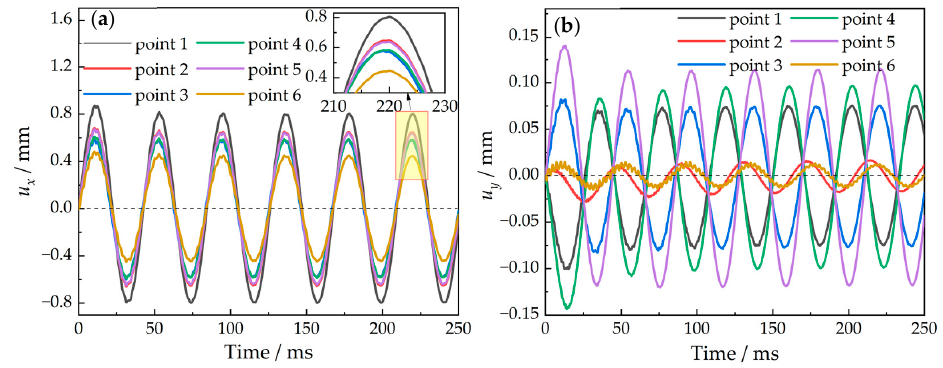
Figure 8. The time history of ( a ) u x and ( b ) u y of the representative points. The feeding channel deformed periodically under vibration, and its deformation am- plified 100-fold at 220 ms and 240 ms is shown in Figure 9. The distortion of the mesh reflected the deformation of the melt micro-units. The displacement was large in the upper feeding channel, but the deformation was small. Conversely, the displacement was small in the lower region, but the deformation was large. The maximal deformation region near the 642 °C isotherm is marked by a red line and named region A in Figure 9a,b. In the positive half-period of the source, the feeding channel was pushed, forming tensile stress in region A, where the dendrites overlapped slightly with weak strength [26]. When the tensile stress reached its maximum, such as at 220 ms, region A developed cracks easily, as shown in Figure 9a. In the negative half-period, the feeding channel was pulled, form- ing compressive stress in region A to press the cracks, as shown in Figure 9b. However, the strength increased with solidification, and the cracks were in a vacuum, promoting the discharge of the gas dissolved in the melt, increasing the resistance to being pressed. If the cracks were not pressed and the melt was not supplemented in time, hot cracks accompanied by shrinkage porosities would form here. As denoted by the red dashed ellipse in Figure 9c, the position and direction of cracks and shrinkage defects coincided with those predicted. The comparison verified the accuracy of the numerical simulation and explained the change in the distribution of shrinkage defects with vibration.